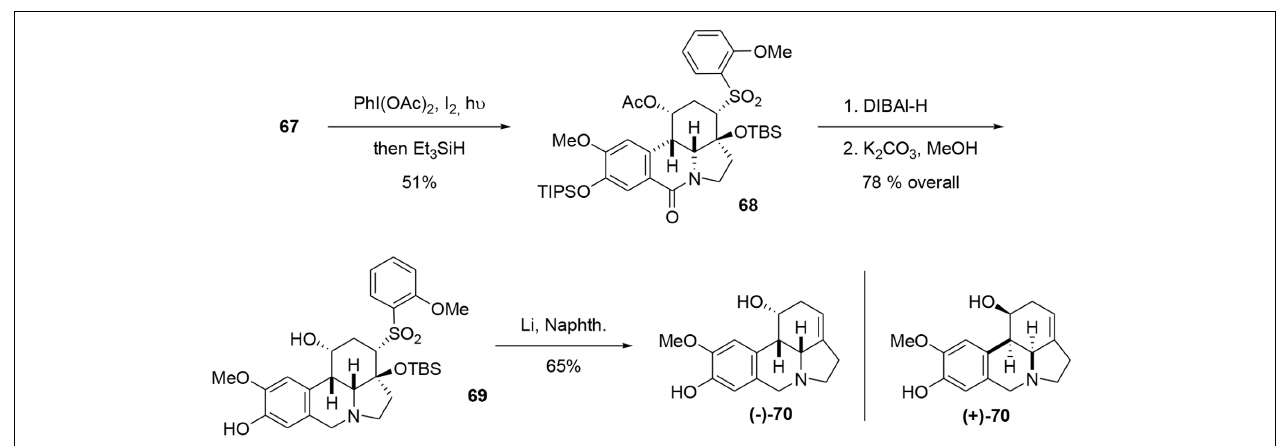
Scheme 19 | End of synthesis and correction of absolute